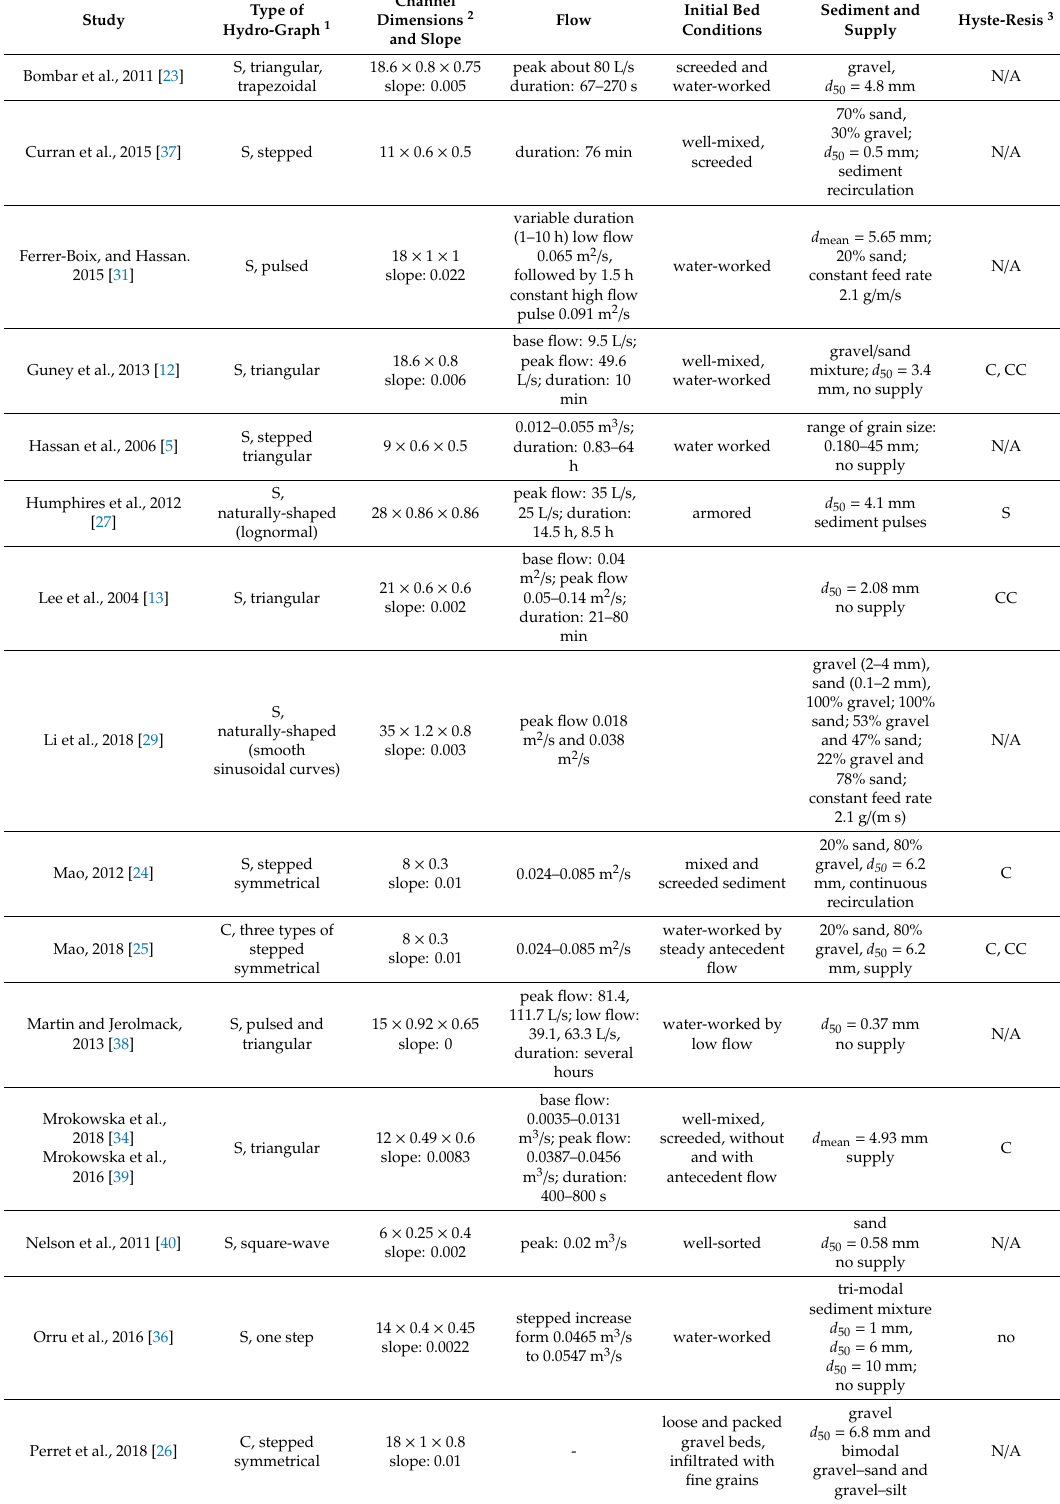
Table 1. Laboratory studies on sediment transport under unsteady flow